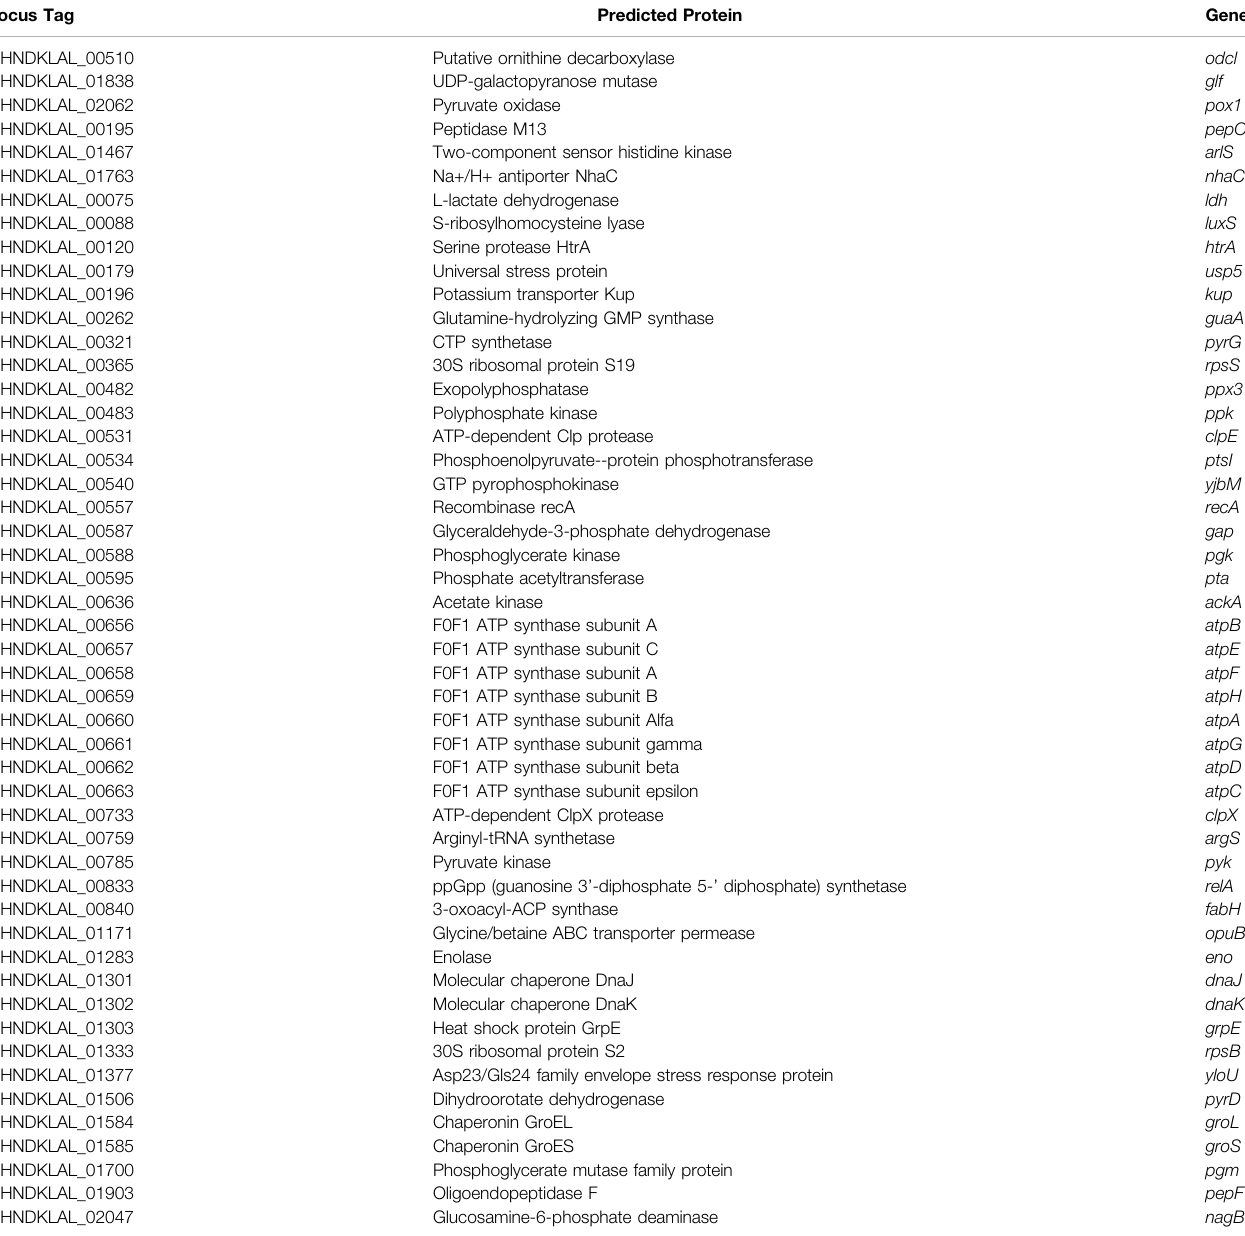
Italics represents the gene ID of predicted proteins related to GIT stress